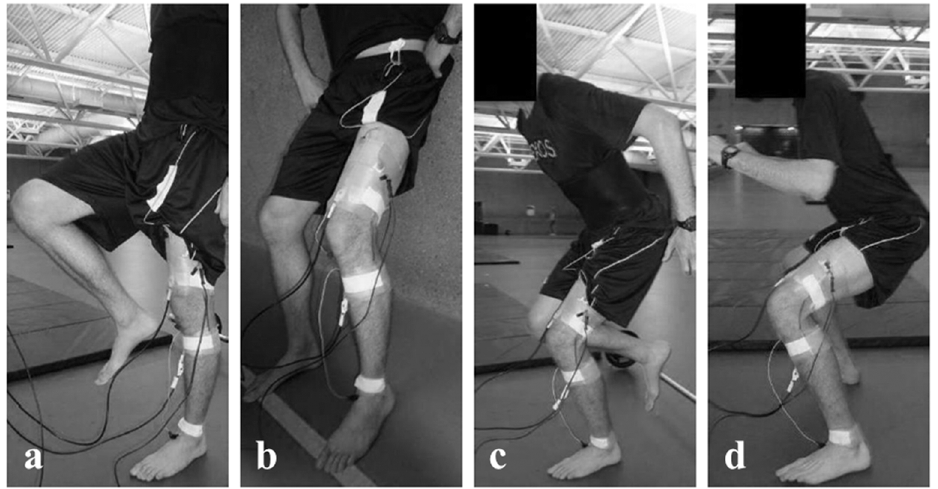
Fig 1. Movement tasks. Single-leg balance (SLB) (a), isometric squat (ISO) (b), single-leg squat (SLS) (c), bipedal squat (BPS)